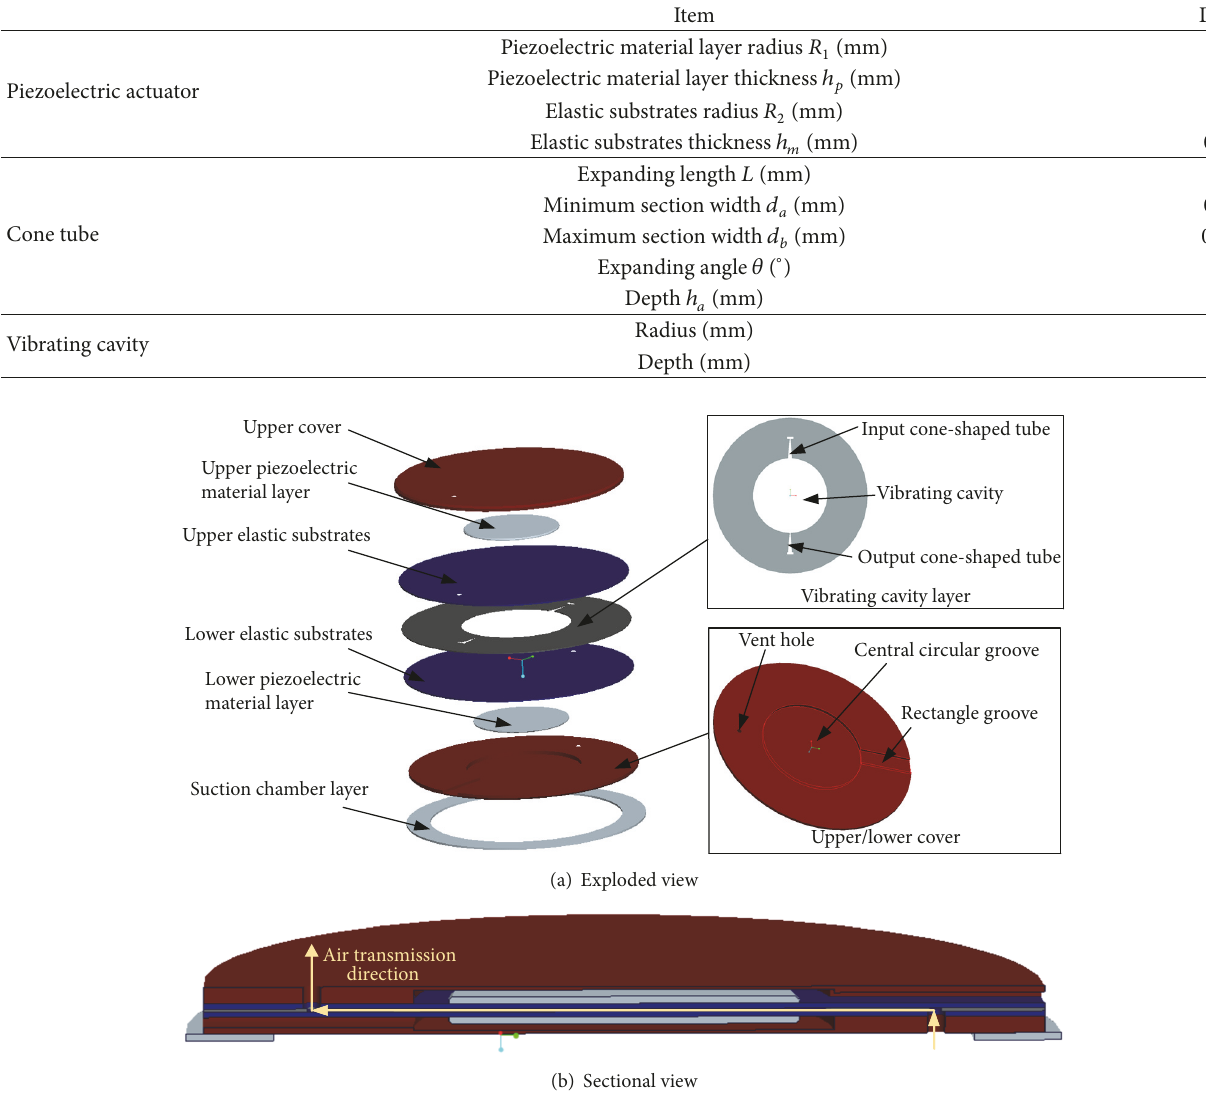
Figure 1: Structure diagram of the suction cup with